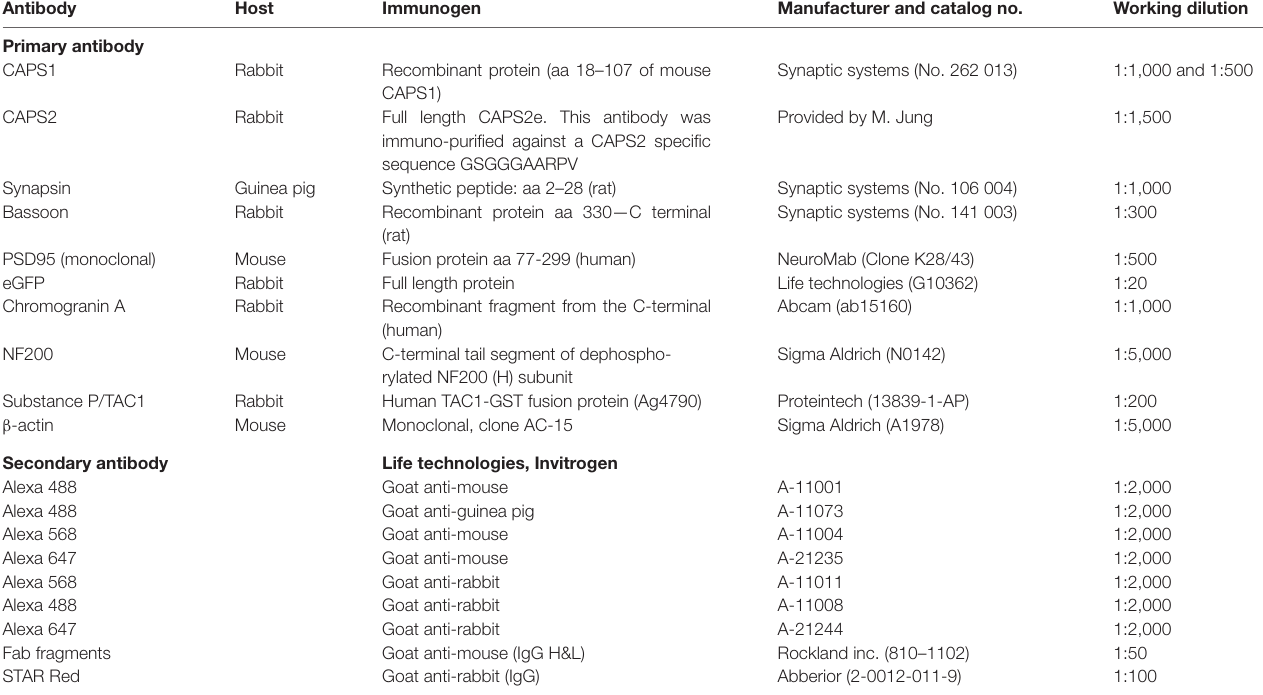
TABLE 1 | Details of antibodies used in the study.